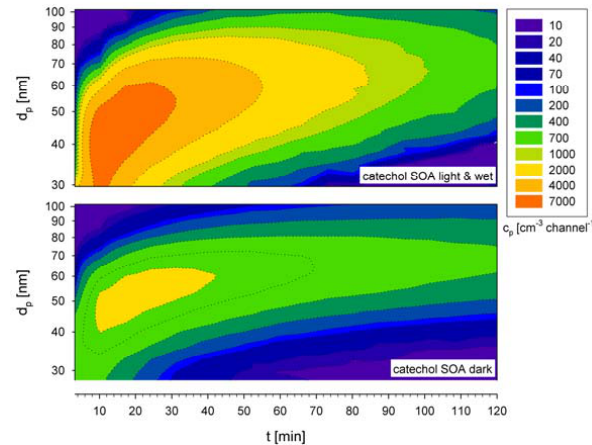
Fig. 3. Evolution of the particle mass concentration (C OA ) over time: The catechol precursor causes higher aerosol mass yields than the guaiacol precursor. Particle formation is strongly influenced by environmental conditions like simulated sunlight and relative humidity.